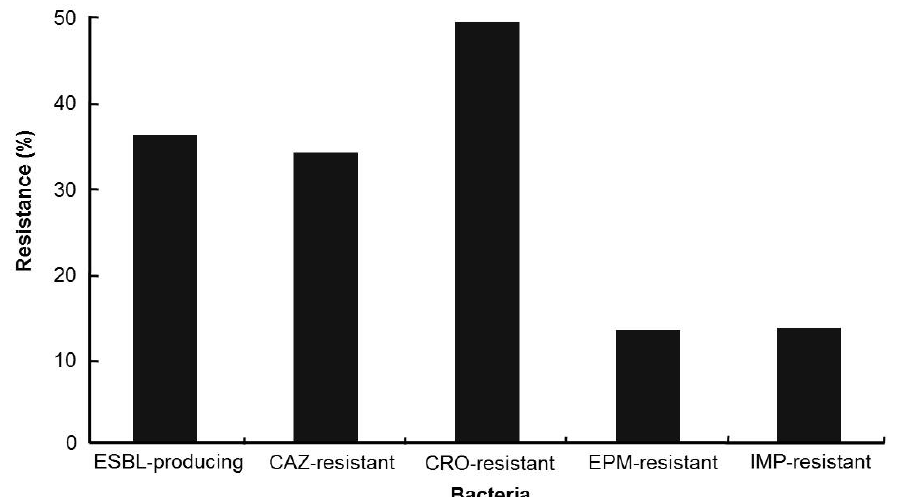
Figure 3. Resistance rates (%) for various antibiotics (CAZ, ceftazidime; CRO, ceftriaxone; EPM, ertapenem; IMP, imipenem) in Enterobacteriaceae isolated from urinary tract infections (UTIs) in the Asia-Pacific region from 2009–2010 results from the study for